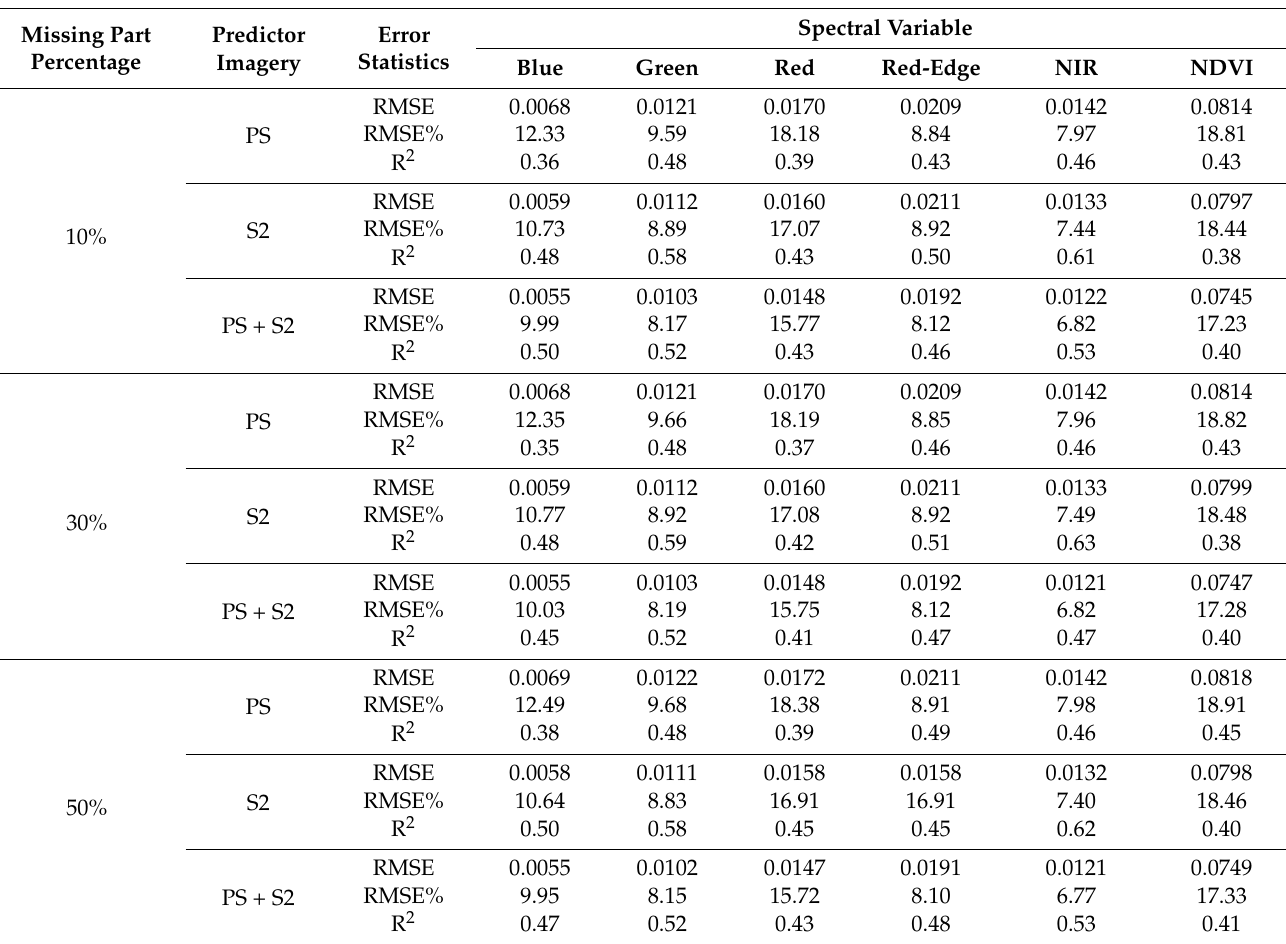
Table 1. Performance of the random forest models in imputing the missing parts of the UAV orthomosaic using PlanetScope (PS) and Sentinel-2 (S2)